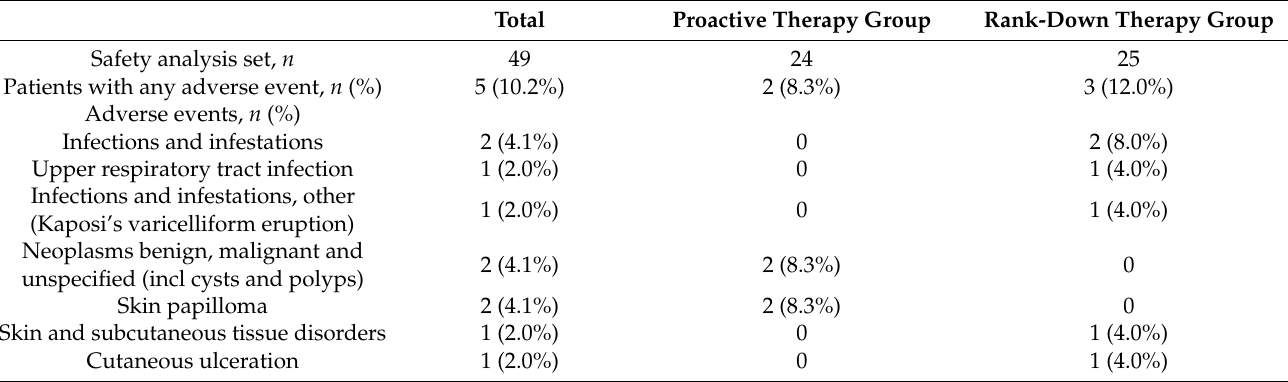
Table 3. Adverse events observed during the study